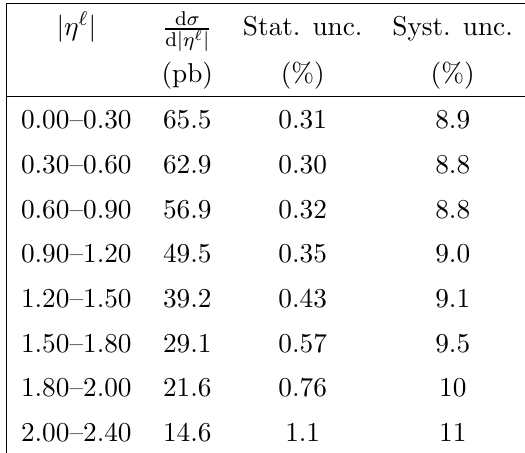
Table 17 . Results of the absolute di(cid:11)erential cross sections with relative uncertainties in the combined channel with respect to